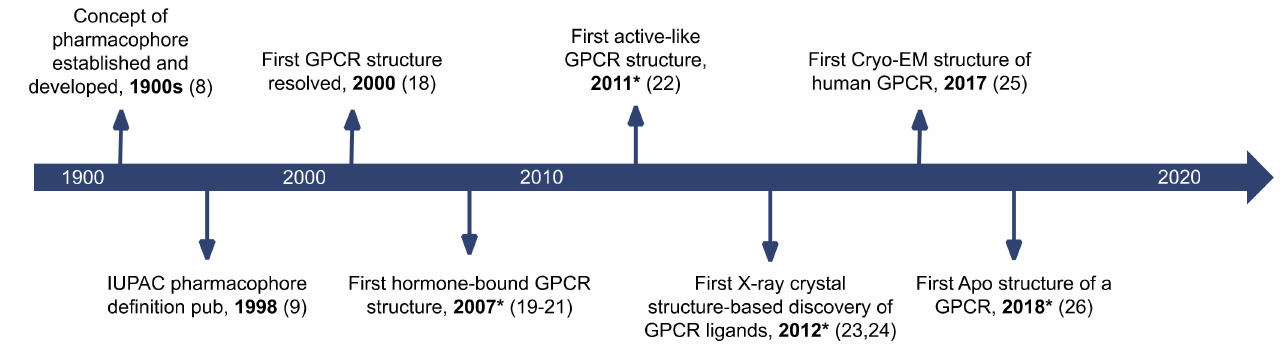
Figure 2. GPCR research milestones related to CADD, * = pharmaceutically